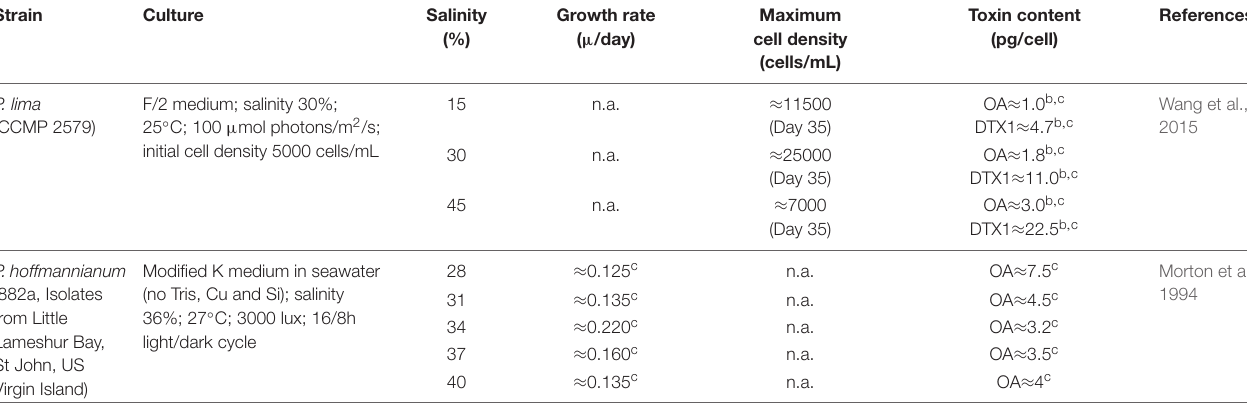
TABLE 4 | Effect of salinity on the growth and toxin content of Prorocentrum spp. Strain